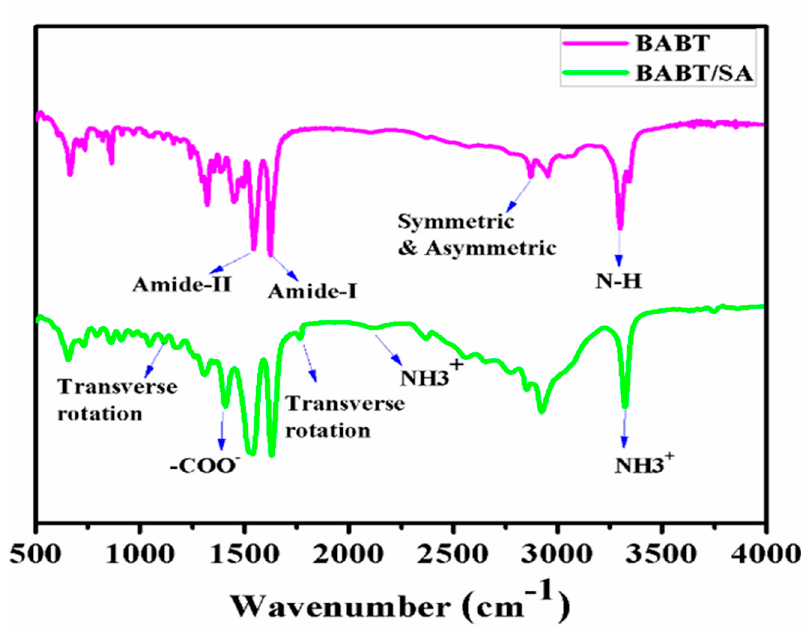
Figure 2. Fourier transform infrared (FT-IR) spectra of BABT diamine and BABT/sebacic acid (SA) salt.